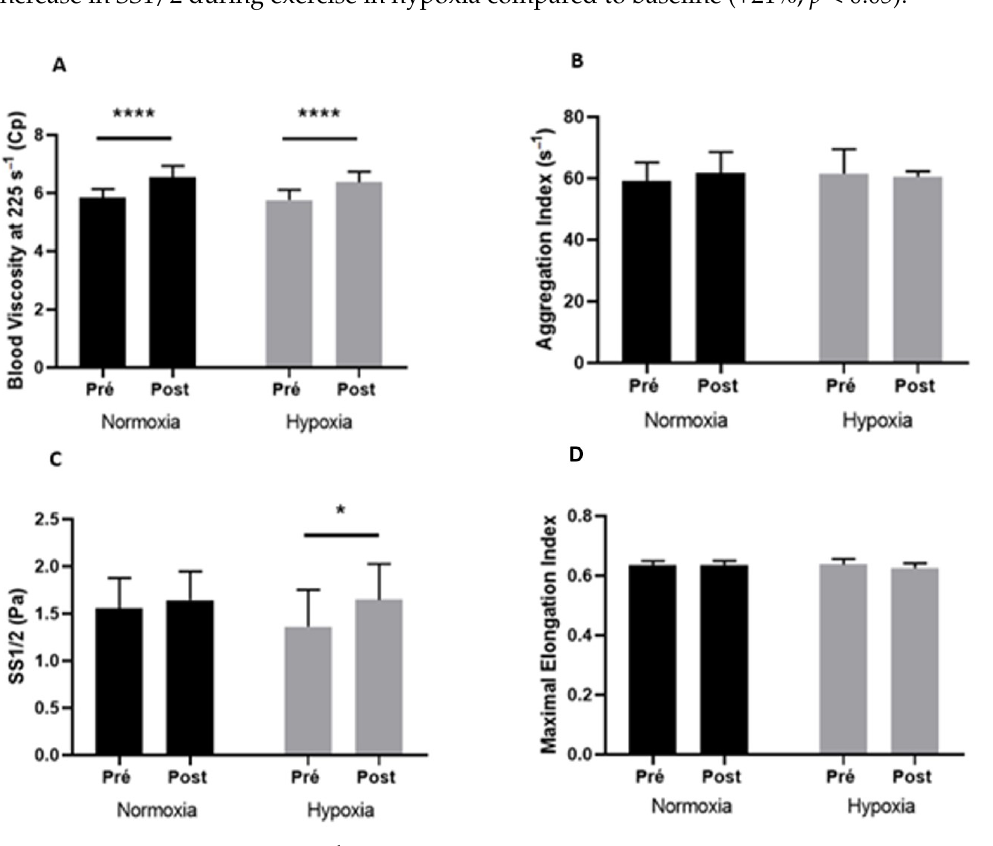
Figure 1. Blood viscosity at 225 s − 1 ( A ), aggregation index ( B ), SS1/2 ( C ), and maximal elongation index ( D ) before (Pre) and after (Post) exercise, in normoxia and in hypoxia. Difference between pre- and postexercise * p < 0.05, **** p <